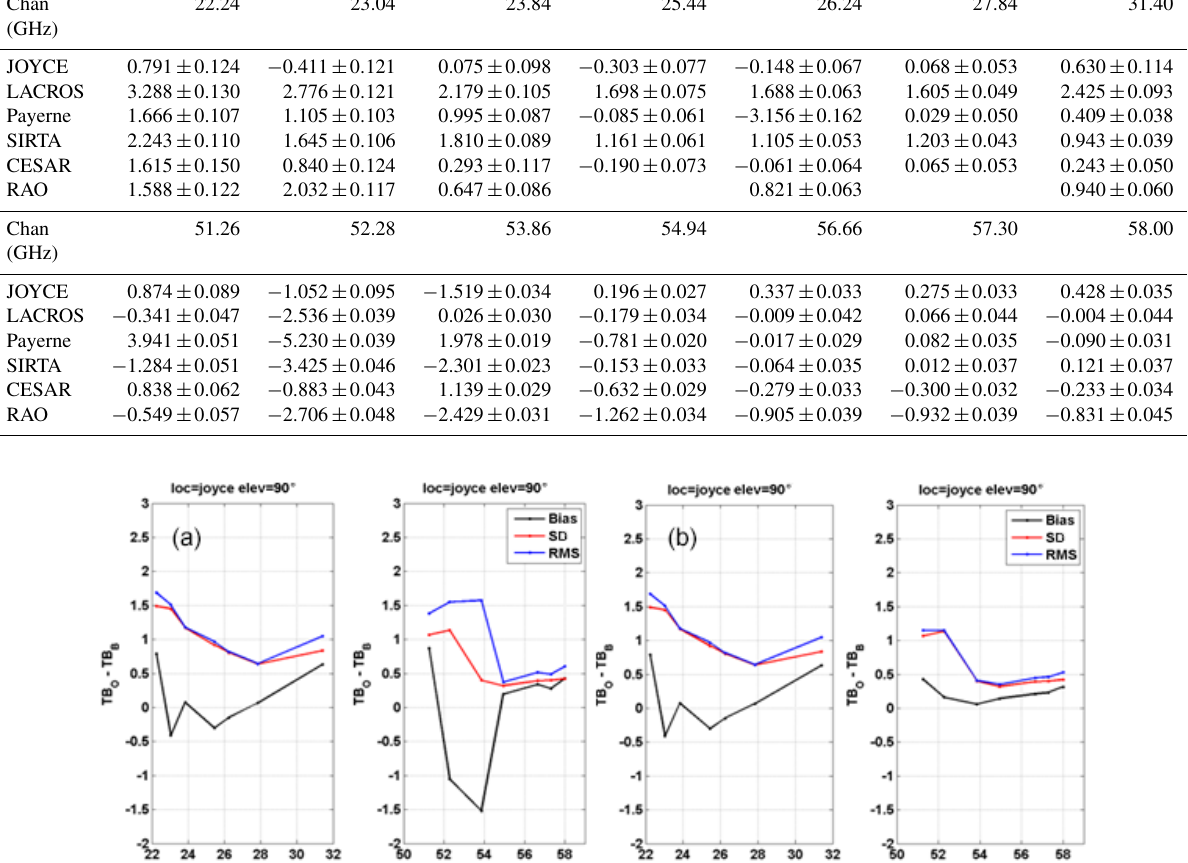
Table 2. Biases of O–B TB differences and their 95% confidence intervals for all the instrumental sites at zenith. Values at RAO (MP3000A) are reported on the column of the closest HATPRO frequency channel.